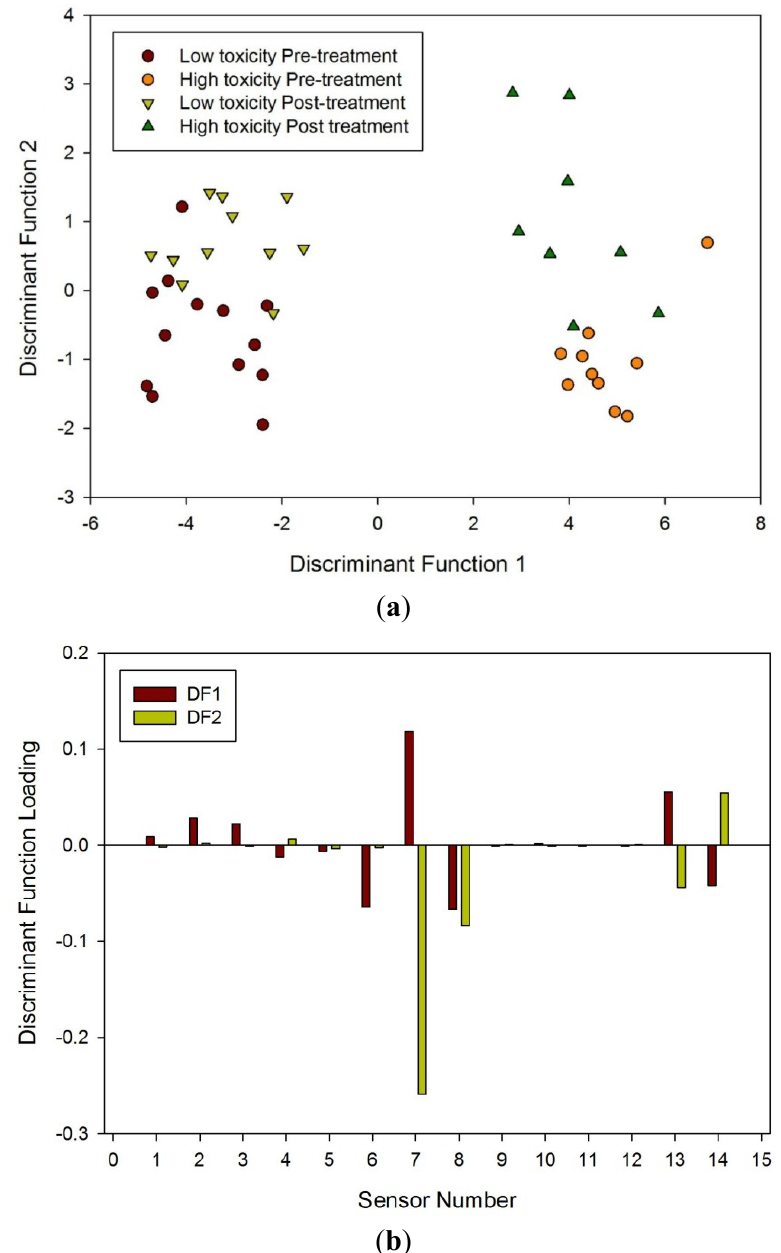
Figure 7. ( a ) LDA of all four groups using the e-nose and ( b ) loading plot associated with LDA referenced to Table